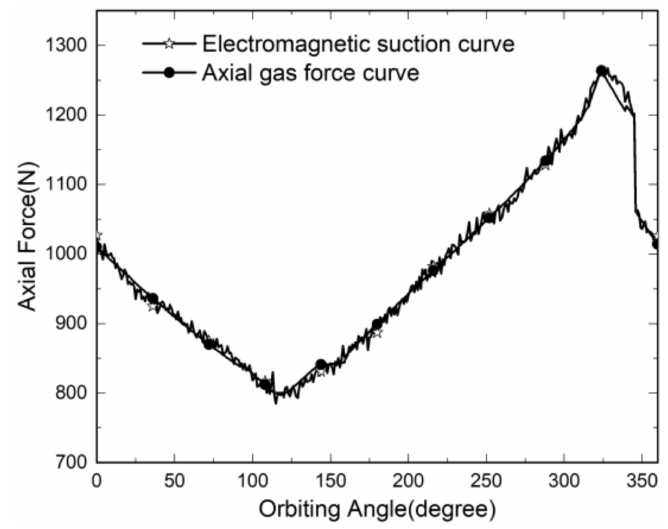
Figure 3. Electromagnetic suction tracking